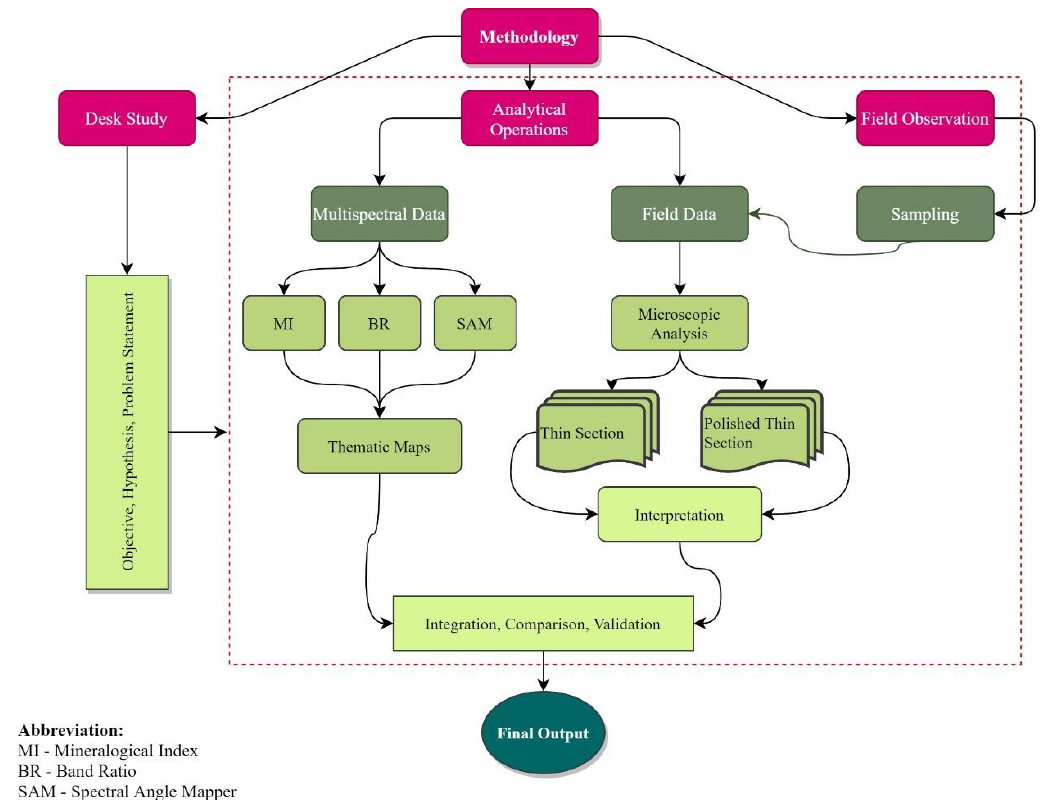
Figure 3. The flow chart of the methodology .